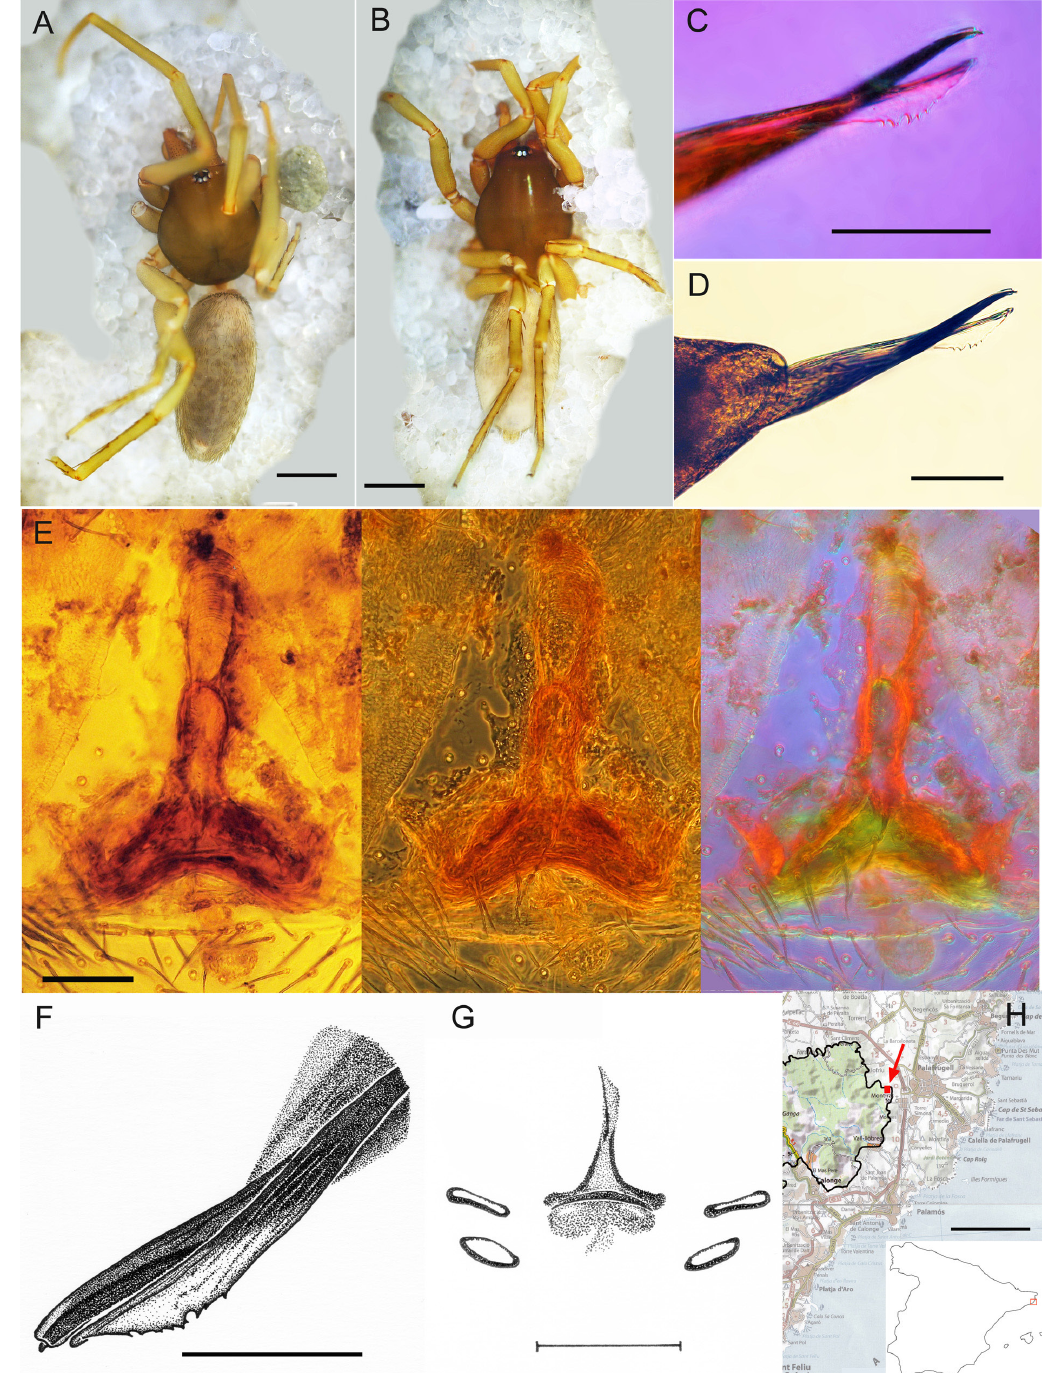
Fig. 2. A–G. Harpactea dufouri (Thorell, 1873), Mont Ras specimens, except F–G . A . ♂, dorsal view. B . ♀, dorsal view. C . Tip of male embolus and conductor, retrolateral view, Nomarski interference contrast. D . Tip of male embolus and conductor, retrolateral view, bright field. E . Cleared vulva, ventral view. Left: bright field, middle: phase contrast, right: Nomarski interference contrast . F . Tip of male embolus and conductor, Banyalbufar specimen. G . Endogyne, external ventral view, Banyalbufar specimen. — H . Map showing the Mont Ras site of Harpactea dufouri (red square), the Gavarres are delimited by a black line. Scale bars: A–B = 1 mm; C–F = 100 µm; G = 0.5 mm; H = 5